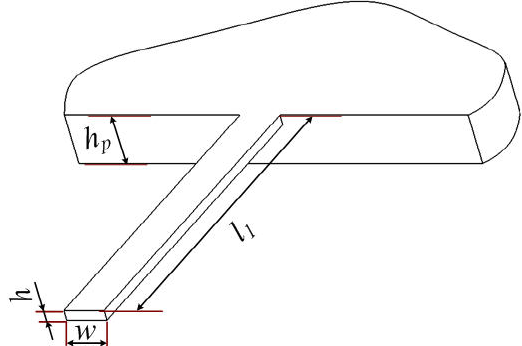
Figure 2. The support model and its main structural